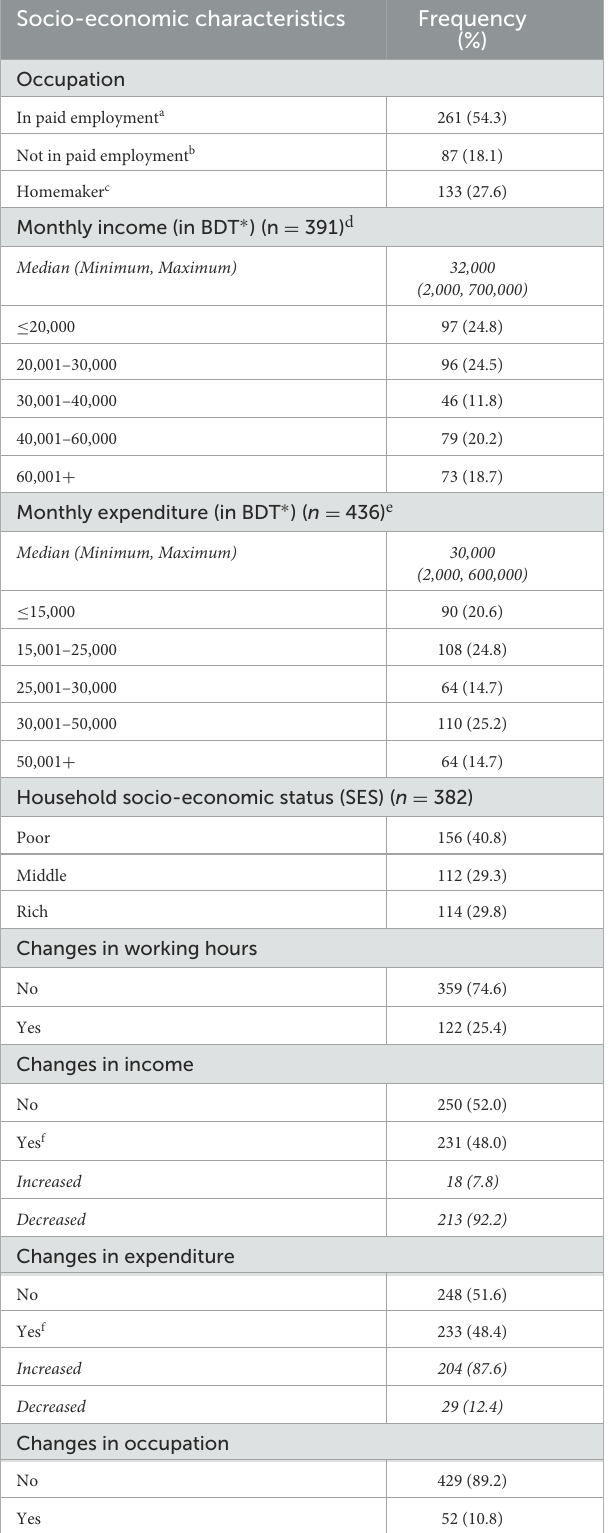
TABLE 2 Frequency and percentage distribution of respondents’ socio-economic characteristics ( N = 481 unless specified otherwise). Socio-economic characteristics